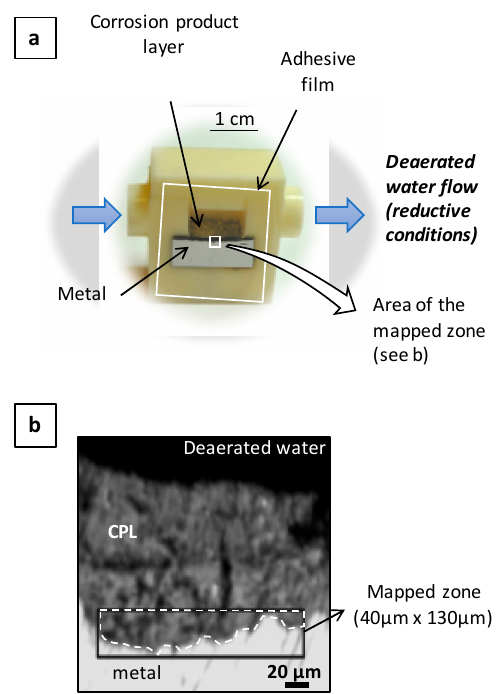
Figure 2. ( a ) In situ experimental cell; ( b ) Optical microphotograph of the transverse section. Black rectangle: zone observed by µRS maps. Dotted line: zone where the phase quantification is performed. CPL: Corrosion Product Layer.